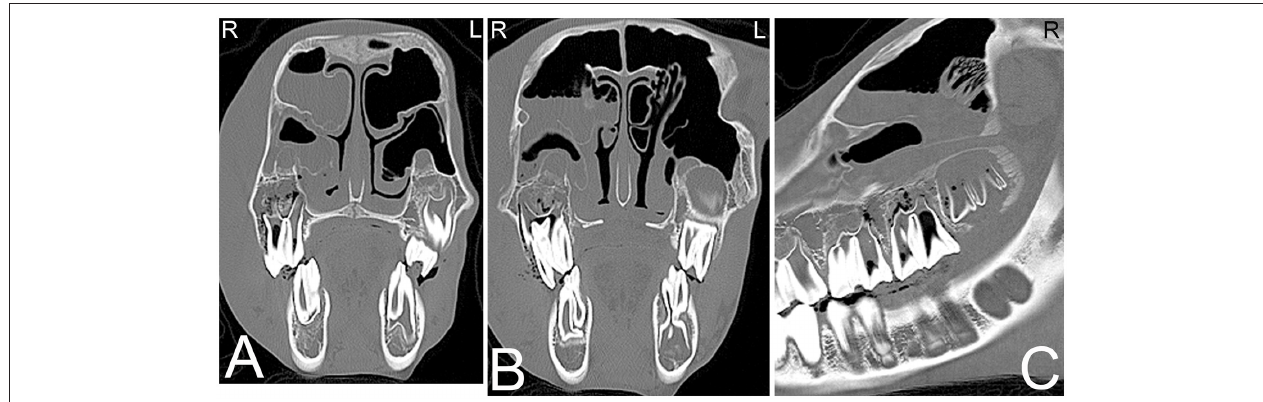
FIGURE 5 | Apical abscessation of multiple deciduous erupted and unerupted maxillary cheek teeth. Transverse (A,B) and sagittal (C) computed tomography images displayed in a bone window of the rostral to mid aspect of the skull of a 2-month-old Fox Trotter foal with a history of swelling of the head for 4 days. Diffuse, small gas opacities are seen within and surrounding the apices of the right maxillary deciduous fourth premolar (Triadan 508), the deciduous third maxillary premolar, and the unerupted permanent first maxillary molar teeth. A moderate amount of dependent fluid is noted in the right maxillary and ventral conchal sinus consistent with sinusitis. Mild widening of the periodontal space around the apices of the mandibular cheek teeth with mild periosteal remodeling along the ventral aspect of both mandibles is present. Marked soft tissue swelling is noted along the entire right side of the head. Culture of sinus fluid and histopathology revealed a severe chronic osteomyelitis of the maxillary bone with fibrinous cellulitis and vasculopathy secondary to a mixed bacterial infection including Staphylococcus and Clostridium. L, left; R,